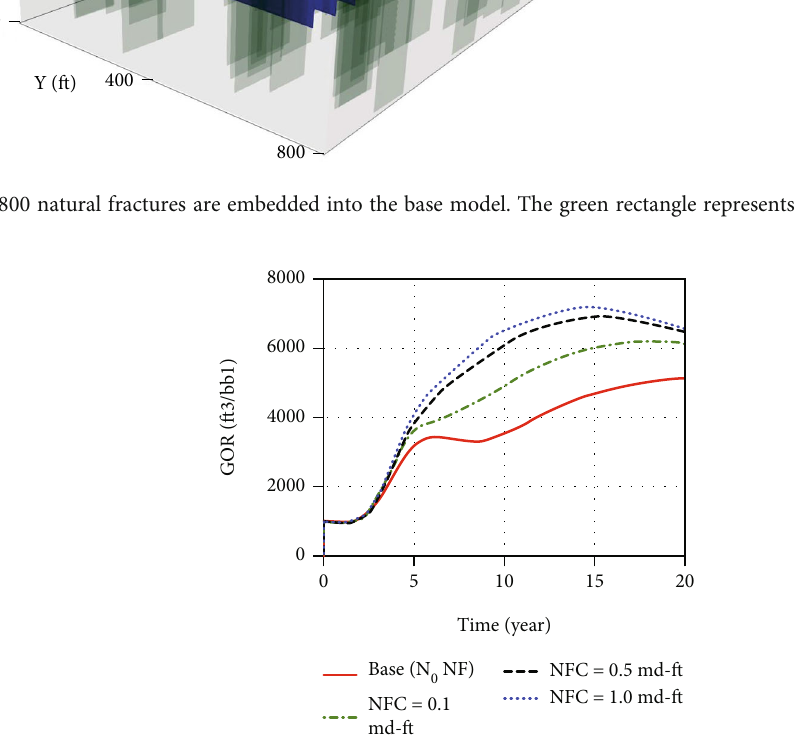
Figure 14: Comparison of 20-year GOR prediction with di ff erent natural fracture conductivity (NFC) ranges from 0.1 to